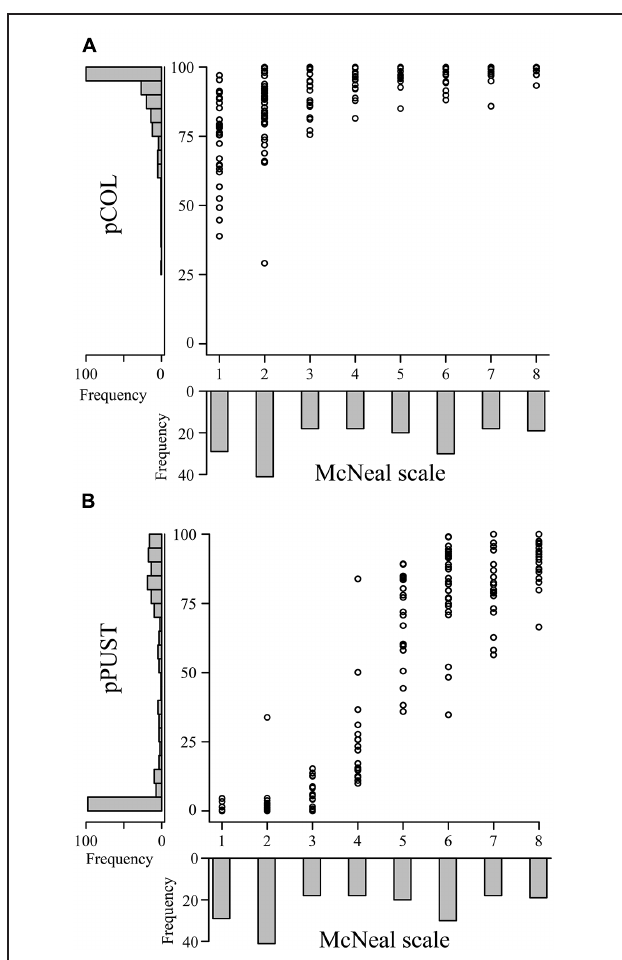
FIGURE 5 | Comparison of macroscopic and microscopic phenotypes in the barley- P. striiformis f. sp. hordei interaction. Plots comparing the macroscopic McNeal scale ( x -axes) with the microscopic phenotypes pCOL (A) and pPUST (B) , ( y -axes) in barley accessions challenged with P. striiformis f. sp. hordei isolate B01/2. Histograms showing the frequency of phenotypic observations are displayed on the corresponding axis for the data shown in the